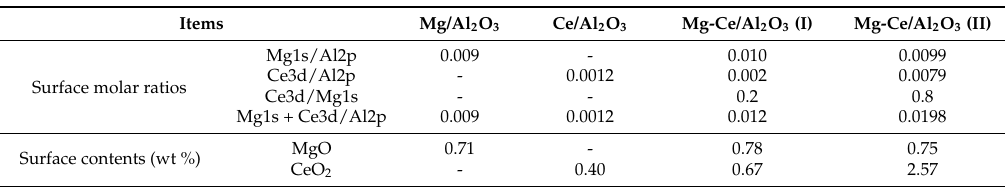
Figure 6. X-ray photoelectron spectroscopy (XPS) spectra of Mg1s ( a ) and Ce3d ( b ) of metal oxide-loaded Al 2 O 3 catalysts. Table 2. Molar ratios of Mg and Ce to Al, and surface contents of MgO and CeO 2 for catalysts by XPS analysis.